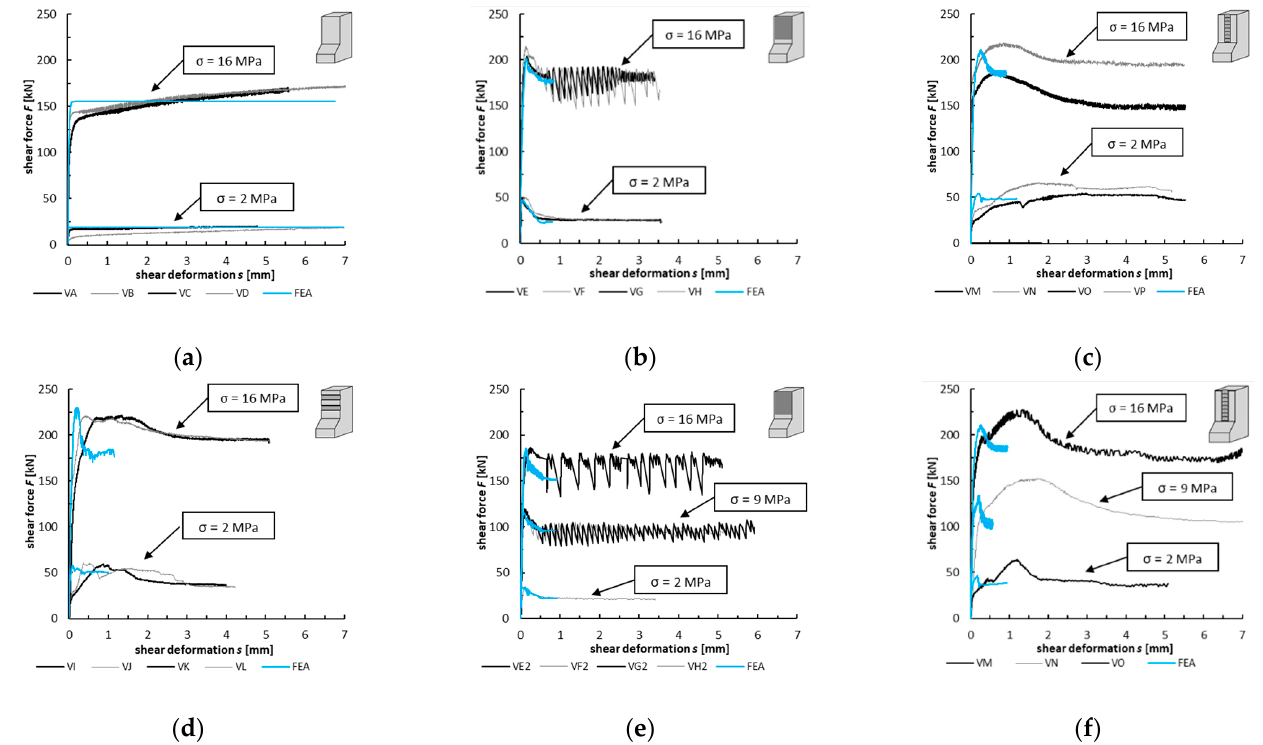
Figure 15. Load-deformation diagrams compared to simulation results for ( a ) dry joint; grout 1: ( b ) plain; ( c ) groove; ( d ) keyed and for grout 2: ( e ) plain; ( f ) grooved, respectively.